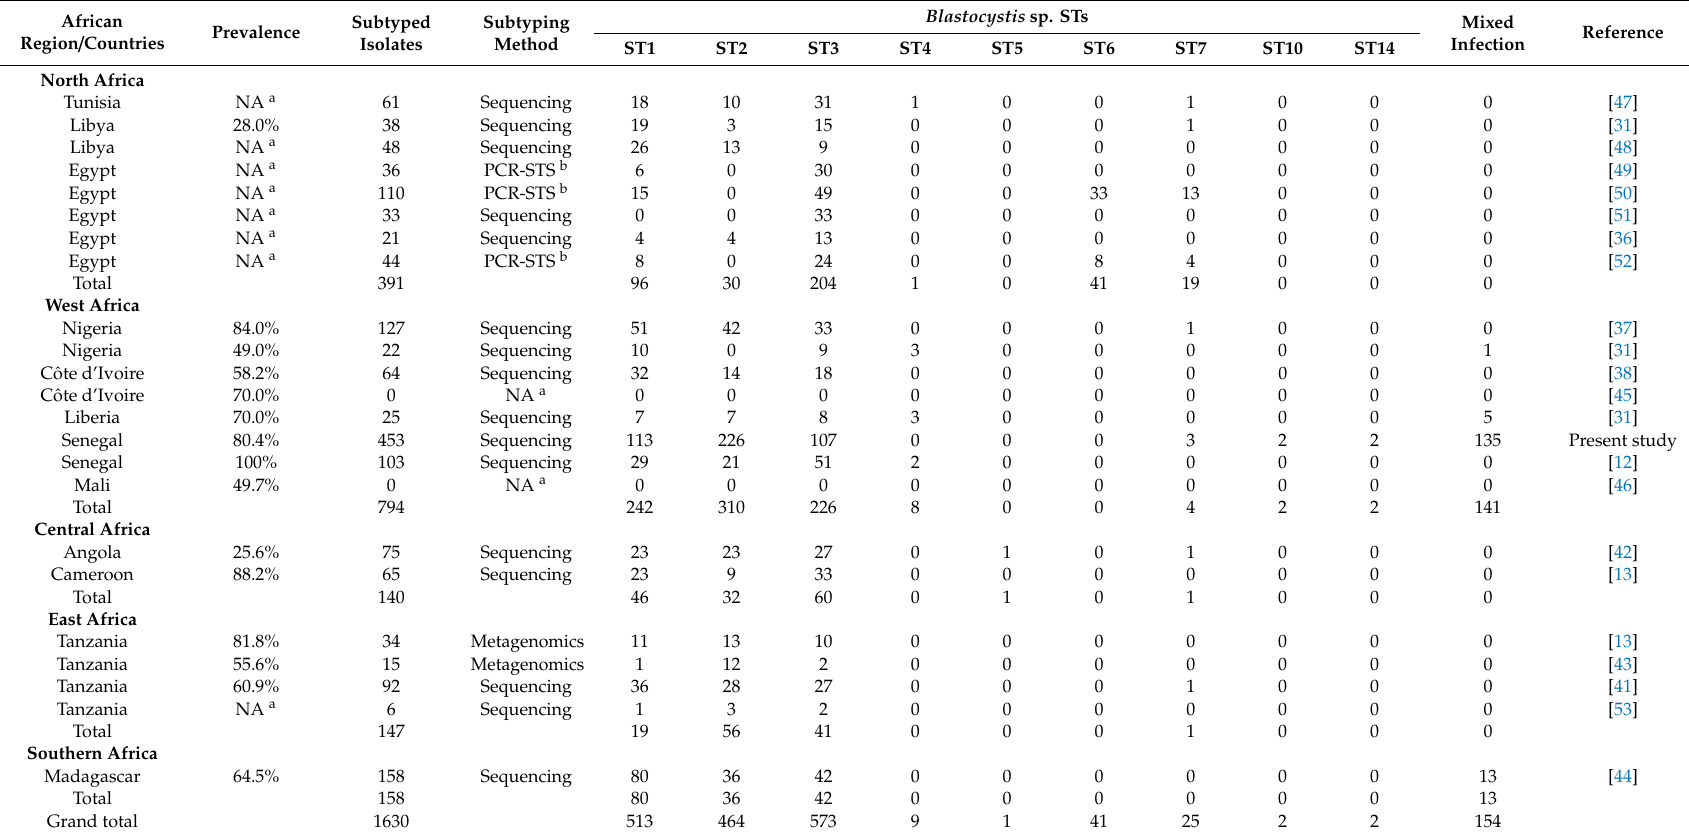
Table 4. Prevalence and ST distribution of Blastocystis sp. in African